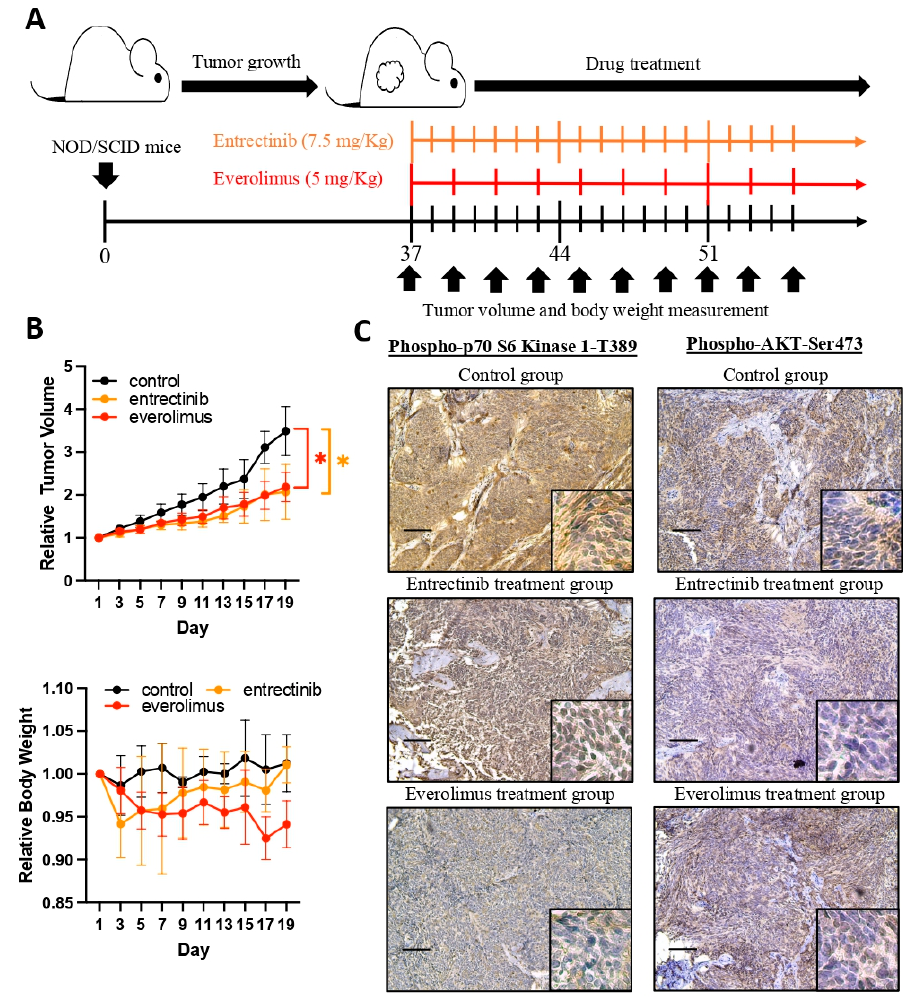
Figure 6. Entrectinib and everolimus treatments inhibit the growth of patient-derived ependymoma xenografts in vivo. ( A ) The drug treatment schedule: entrectinib (7.5 mg/kg, every day), everolimus (5 mg/kg, once every two days), or saline was injected (i.p.) into the patient-derived ependymoma xenograft for three weeks. The tumor volume and body weight were recorded every two days. ( B ) The figure shows the relative tumor volume and body weight compared with those at the first drug feeding. * p < 0.05. ( C ) IHC staining for the detection of phospho-p70 S6 kinase and phospho-AKT expression after treatment with entrectinib or everolimus. Scale bar: 100 µm.